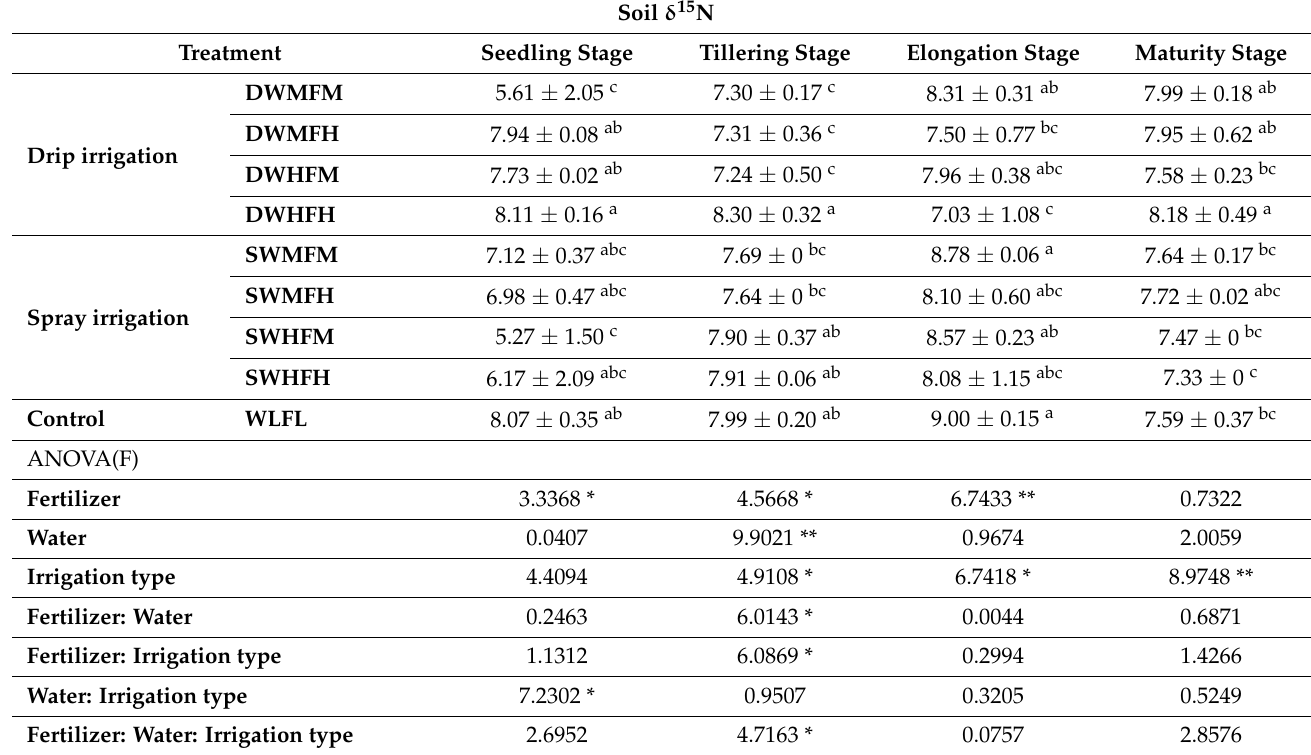
Table 4. Nitrogen isotope ( δ 15 N) content in soil at different growth stages of sugarcane under different water-fertilizer treatments (for abbreviations, see Table